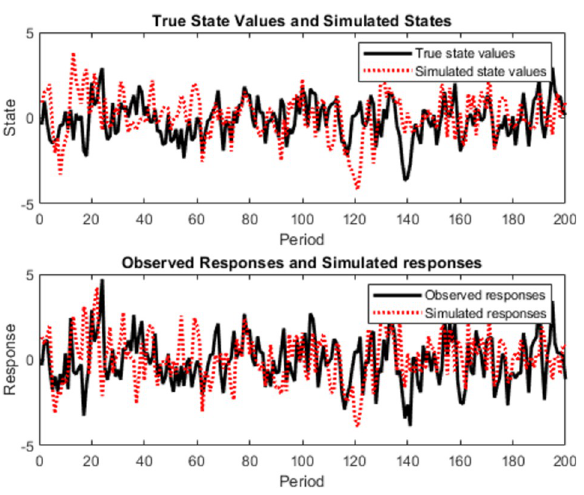
Fig 8. Plot of true state values and simulated states alongside with observed responses and simulated responses at a series of 200 observations.